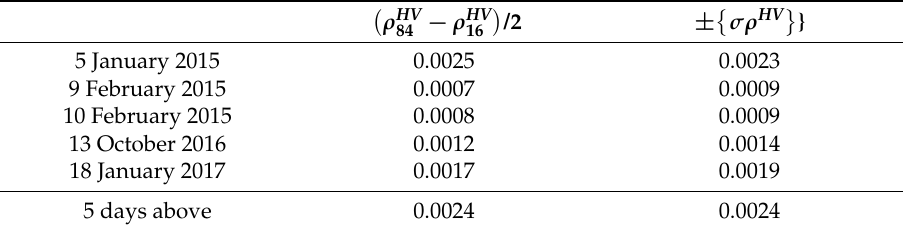
Table 8. Values of spread and standard deviation for the copolar correlation